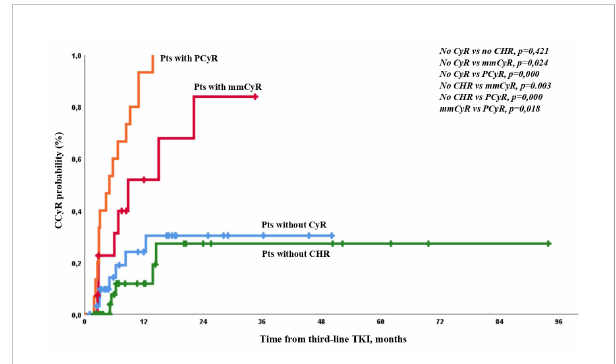
FIGURE 2 Probability of CCyR achievement in the different groups of patients according to the level of response at baseline.